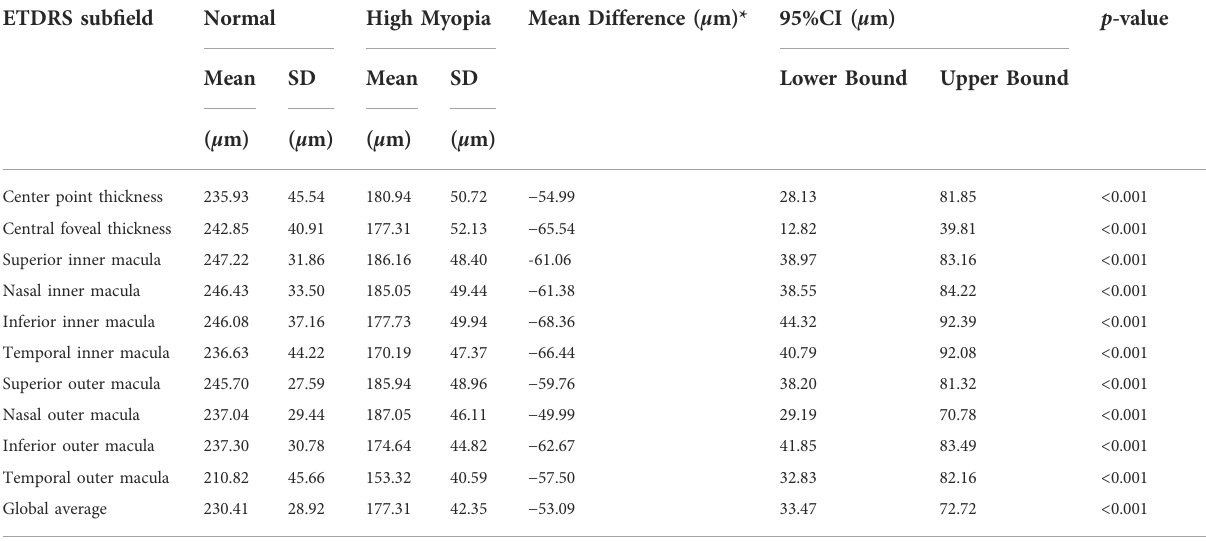
* Normal group as reference, SD, means Standard